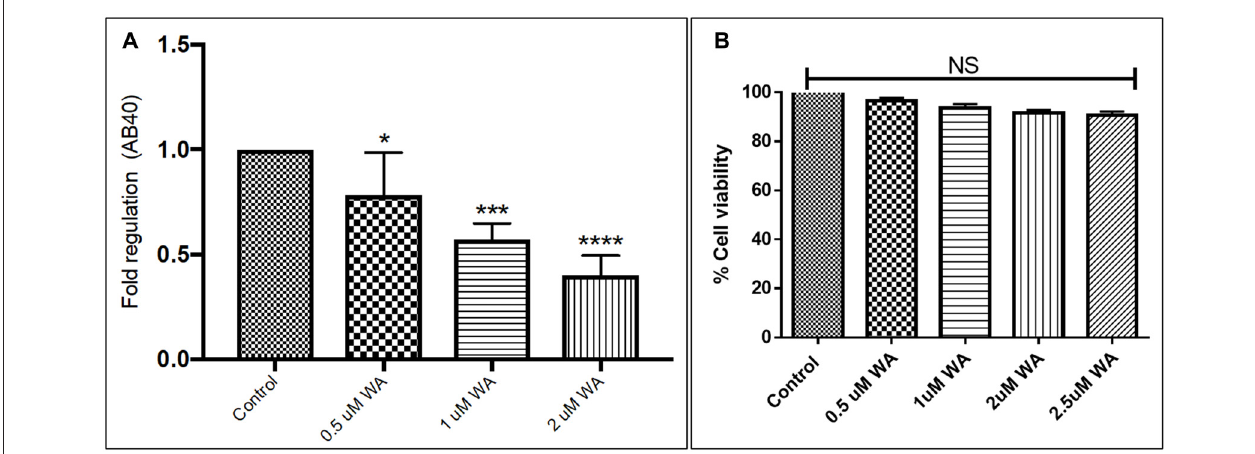
FIGURE 1 | Effect of Withaferin A (WA) on amyloid beta (A β ) secretion. (A) Cells were treated with different dose of WA and the supernatants were collected 48 h after treatment. The supernatant collected were analyzed by A β 1–40 ELISA which demonstrated that at an optimum dose of 2 µ M WA, the levels of secreted A β 40 showed significant decrease compared to control untreated samples. (B) The dosage of WA used for this experiment were also analyzed for the associated cellular toxicity. The cell toxicity assay showed that the lower doses of WA were not toxic to cells. Optimum dose of 2 µ M, WA did not cause any loss in cell viability or toxicity in amyloid precursor protein (APP)-plasmid transfected SH-SY5Y (SH-APP) cells ( ∗ p ≤ 0.05; ∗∗∗ p ≤ 0.001; ∗∗∗∗ p ≤ 0.0001).